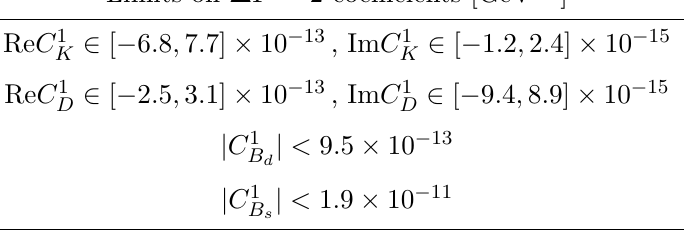
Table 8 . Limits on (cid:1) F = 2 operators from meson anti-meson mixing from [94] (2018 update).